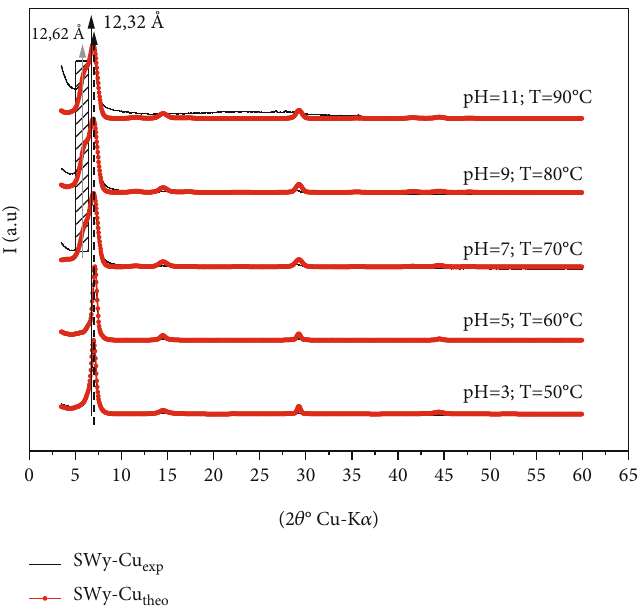
Figure 7: Best agreement between theoretical and experimental XRD pro fi les obtained in the case of